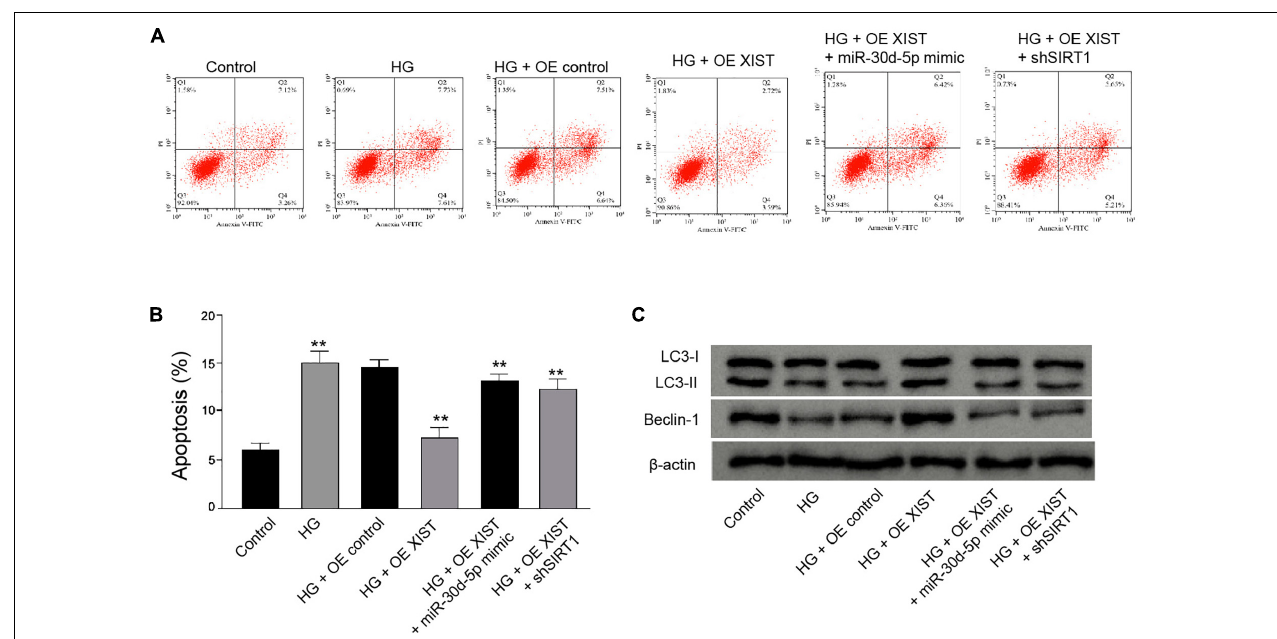
FIGURE 8 | XIST attenuates high glucose-induced apoptosis and induces autophagy by miR-30d-5p/SIRT1 axis in the HG-treated Schwann cells. (A–C) The HG-treated RSC96 cells are treated with pcDNA-3.1-XIST overexpression vectors, or co-treated with pcDNA-3.1-XIST overexpression vectors and miR-30d-5p mimic or SIRT1 shRNA. (A,B) The apoptosis is detected by flow cytometry analysis. (C) The expression of LC3I, LC3II, and Beclin-1 is assessed by Western blot analysis. N = 3, mean ± SD, ** P <